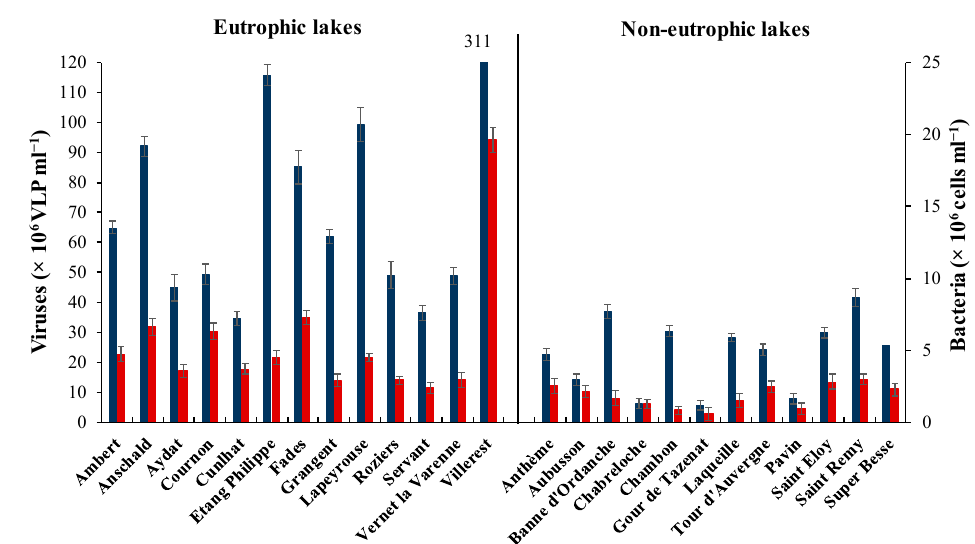
Figure 1. Flow cytometry abundances of viruses and bacteria in the eutrophic and non-eutrophic set of lakes. Data represents mean ± SD (n = 3).